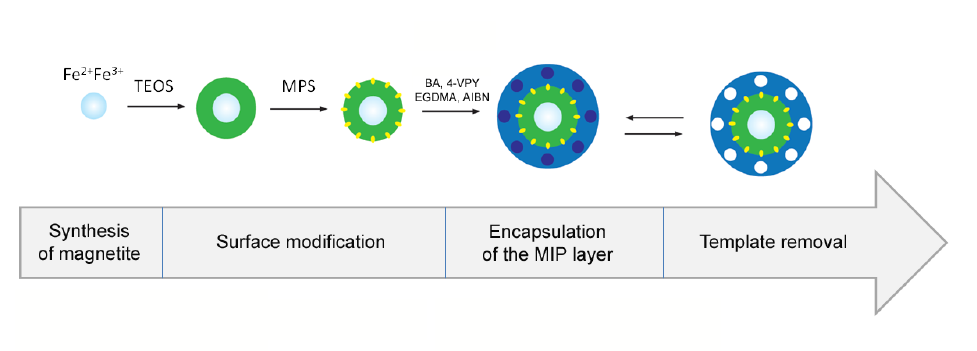
Figure 4: A scheme of preparation of a magnetic molecularly imprinted polymer [29]. Table 1: Summary of the techniques used for the characterization of the MIP and MMIP.